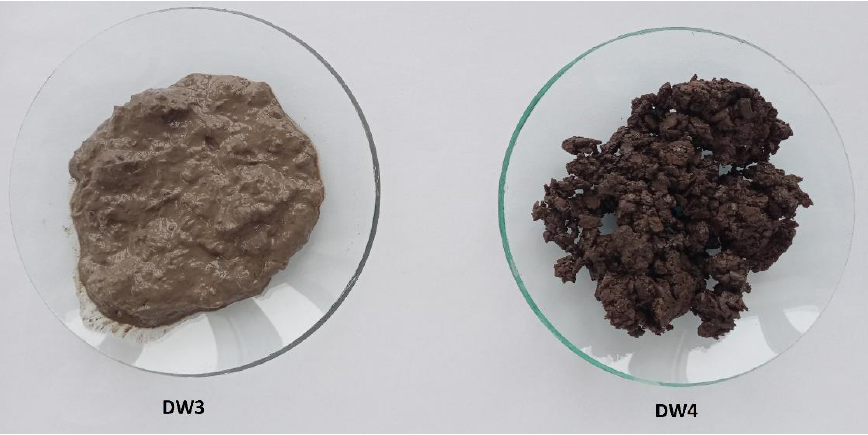
Figure 2. Photographs presenting drilling waste DW3 (code 01 05 07) and DW4 (code 01 05 05*) (photo: M. Gajec).